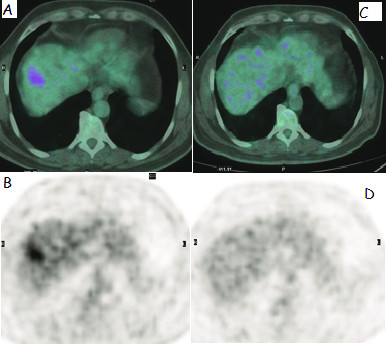
60 years-old male patient who took 1.2GBq Y-90 microsphere therapy to the right lobe of the liver for HCC. 4A, 4B: axial- fused and PET images of the liver before the treatment. 4C, 4D: axial- fused and PET images of the liver after the treatment.